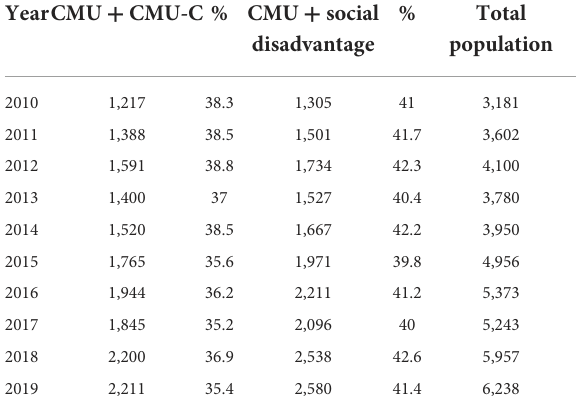
TABLE 8 Levels of social disadvantage among ADHD children and adolescents.